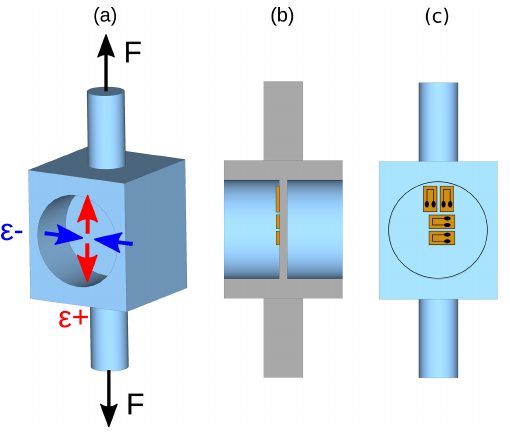
Figure 2. (a) Model of a tension and compression force transducer with applied force “F” and resulting compressive ( (cid:15) − ) and tensile ( (cid:15) + ) strain on the membrane surface. (b) Sectional view of the transducer shows the position and thickness of the membrane and the attached strain gauges. (c) Front view of the force transducer with positions of the strain gauges (Mathis et al.,